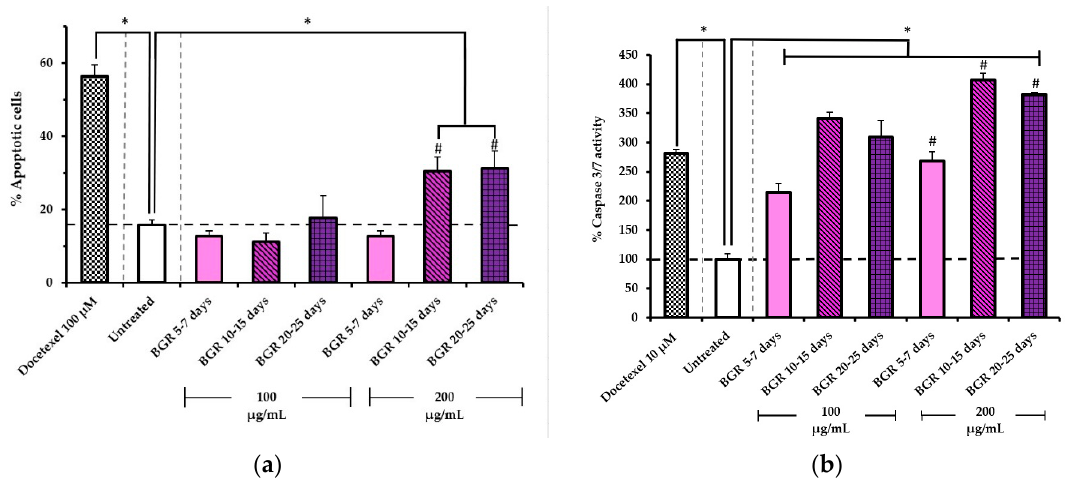
Figure 3. ( a ). % Apoptotic cell of Jurkat cells after 24 h incubation with rice sprouts (BGR) at different